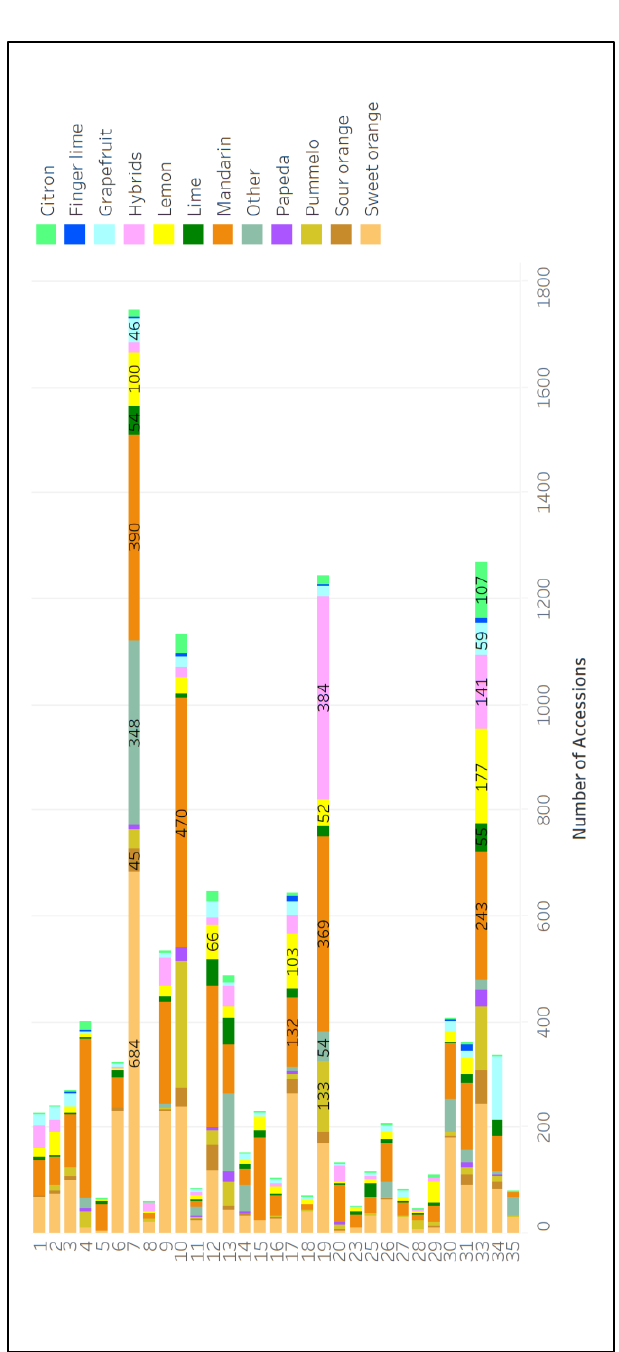
Figure 5. The number of accessions of each fruit type in each citrus collection (collection identity numbers correspond to the first column of Table